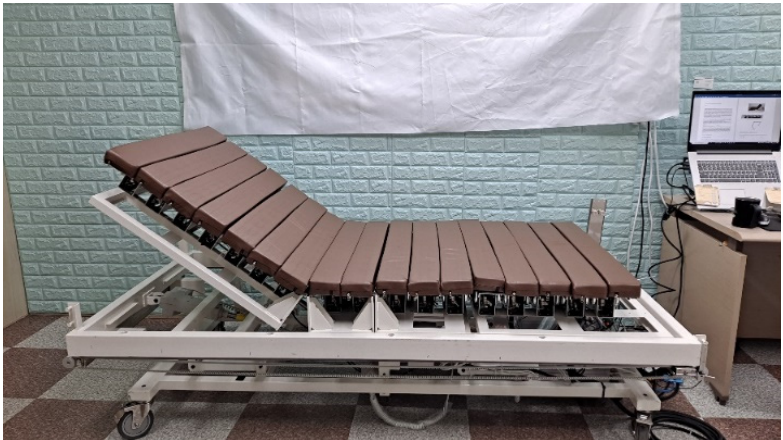
Figure 1. The developed medical bed.